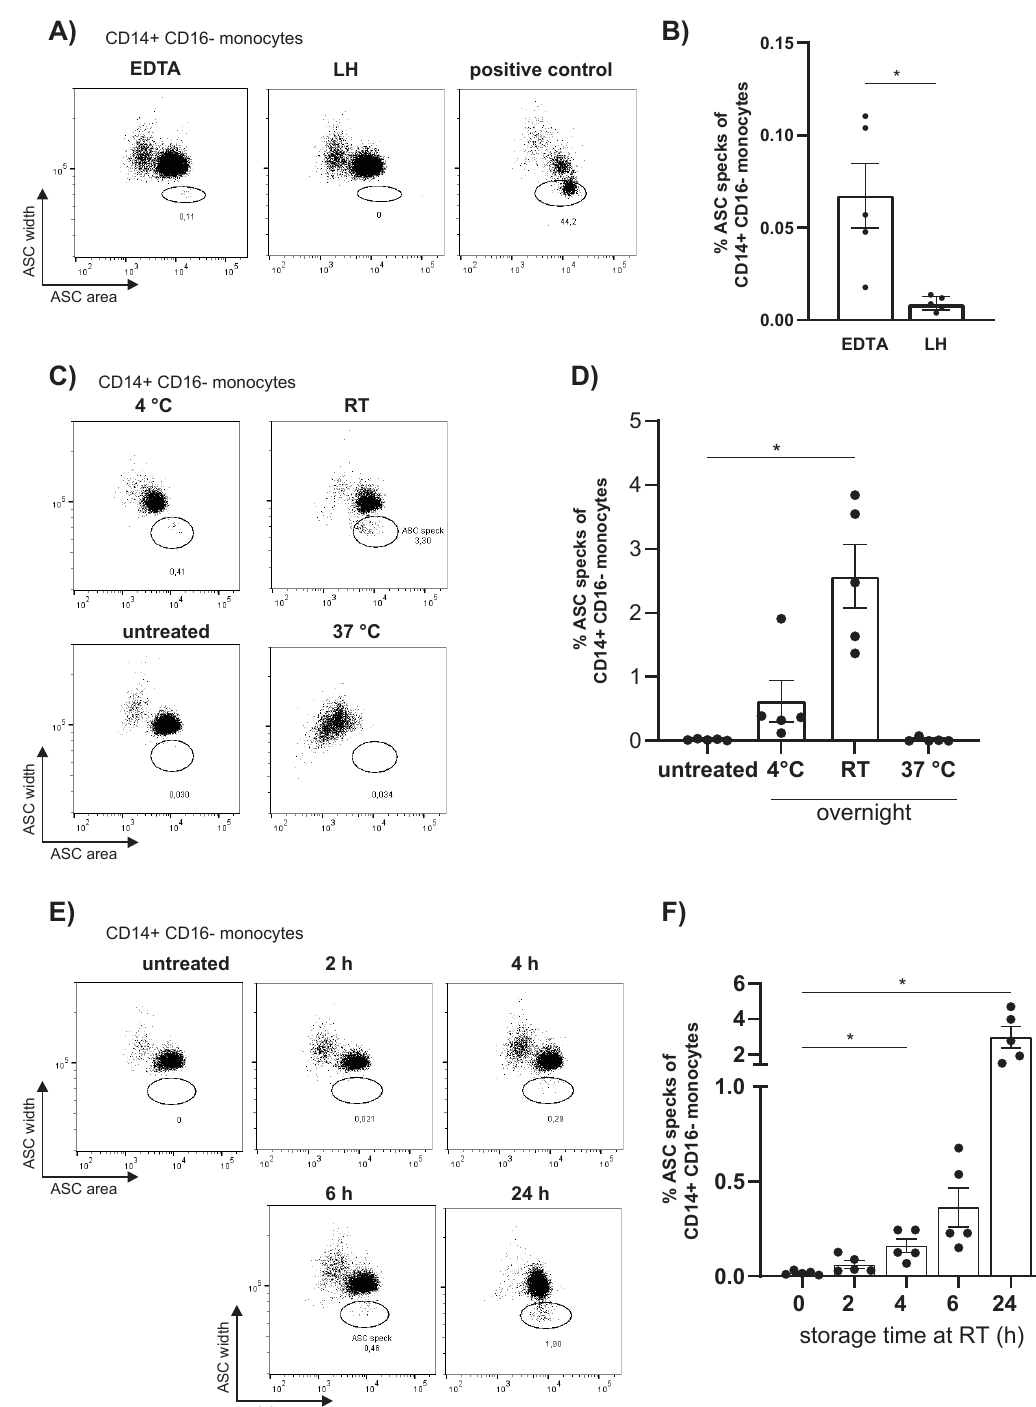
Figure 1. The choice of anticoagulant, storage temperature, and storage time of whole blood impact the unspecific formation of ASC speck + cells in unstimulated monocytes. ( A ) Representative dot plots and ( B ) quantification of data of CD14 ++ CD16 − monocytes for intracellular ASC pulse width vs. area isolated from EDTA- and LH blood in A) compared to LPS 4 h and Nig 20 min stimulated PBMCs. ( C ) Representative dot plots and ( D ) quantification of data of CD14 ++ CD16 − monocytes isolated either directly after blood draw (untreated) or after storage of blood for 24 h at 4 ◦ C, RT, or 37 ◦ C. ( E ) Representative dot plots and ( F ) quantification of data of CD14 ++ CD16 − monocytes isolated either directly after blood draw or after 2 h, 4 h, 6 h, or 24 h at RT. For statistics, paired two tailed t-test was used for ( B ) and repeated measure one-way ANOVA, followed by Bonferroni multiple comparison test for ( D , F ). p -Value * p < 0.05 was considered significant ( n = 5 measured as triplicates and represented as the mean value from these, from three independent experiments, shown mean ±